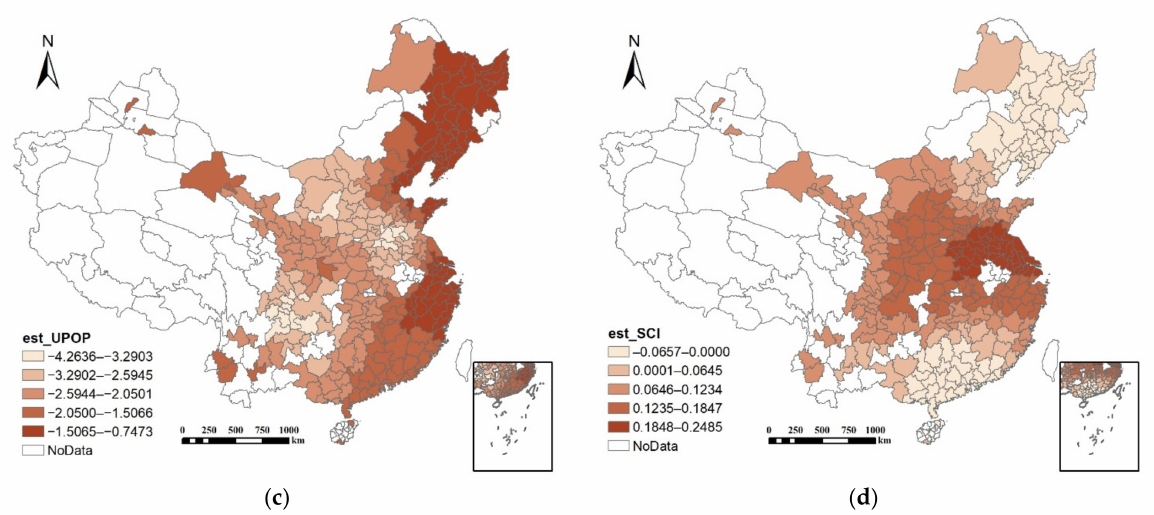
Figure 7. Local regression coefficient of control variables. ( a ) Local coefficients of FAI, ( b ) local coefficients of INCOME, ( c ) local coefficients of UPOP, ( d ) local coefficients of